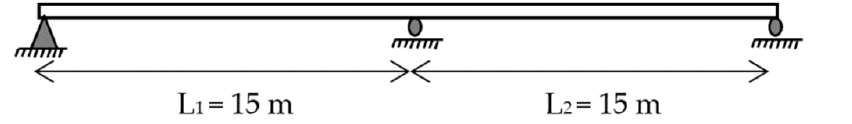
Figure 9. Two-span continuous bridge. Table 9. Identification results for a two-span continuous bridge.